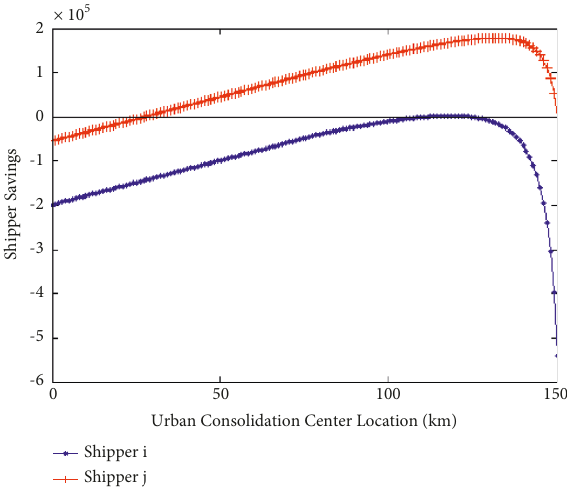
Figure 8: Savings curves of the two shippers when x